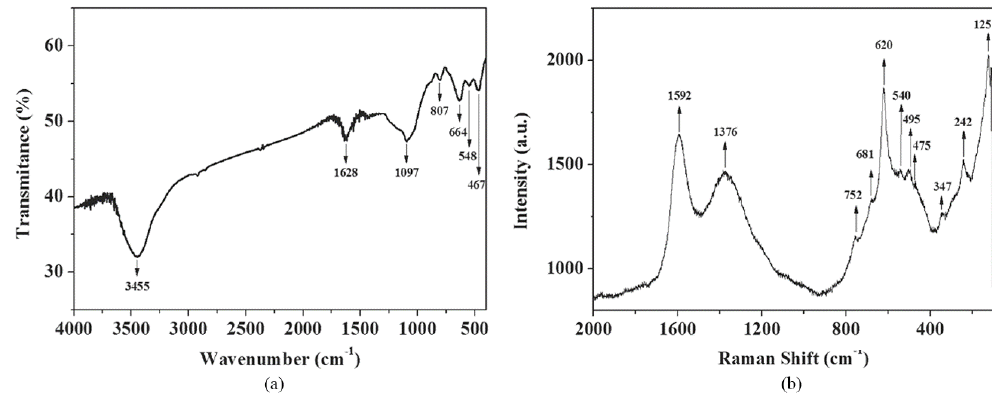
/SiO nanocomposite (a) FT-IR (b) Raman. 2 2 /SiO nanocomposite. Table 3. Assignments of the Raman bands for the SnO 2 2